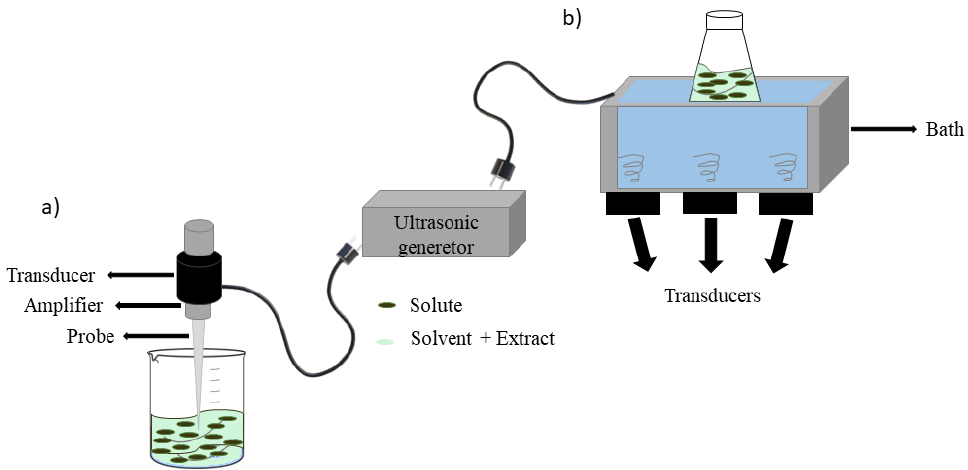
Figure 4. ( a ) Ultrasonic probe system and ( b ) ultrasonic bath